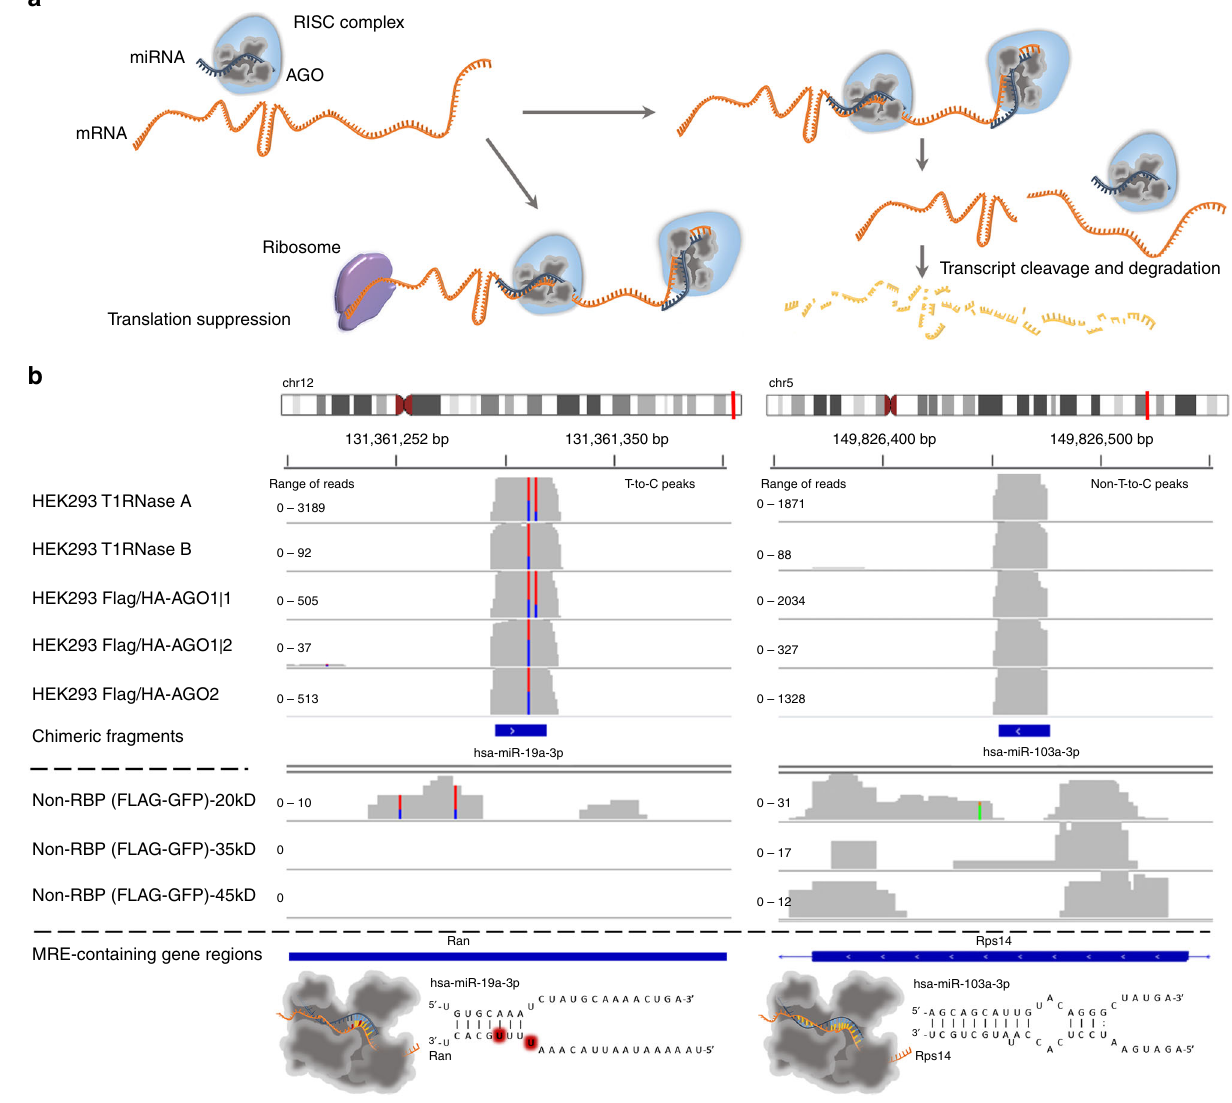
Fig. 1 Argonaute crosslinking and immunoprecipitation experiments enable the high-throughput capturing of miRNA targets. a Illustration of miRNA targeting. miRNAs are loaded on AGO2 and guide the RISC complex to target MRE(s). RISC binding to its target genes can either cease their translation or induce their cleavage and/or degradation. b Peaks derived from 5 AGO-PAR-CLIP libraries on HEK293 cells and from 3 non-RBP background libraries are presented for T-to-C and non-T-to-C AGO-bound regions. The red-and-blue vertical lines represent T-to-C transition sites. Both types of AGO-enriched clusters are clearly distinguished from background signal. Chimeric miRNA-target fragments overlap with (non-)T-to-C peaks providing direct validation for speci fi c miRNA-target pairs (hsa-miR-19a-3p – Ran and hsa-miR-103a-3p – Rps14 ). microCLIP identi fi es the aforementioned interactions as a